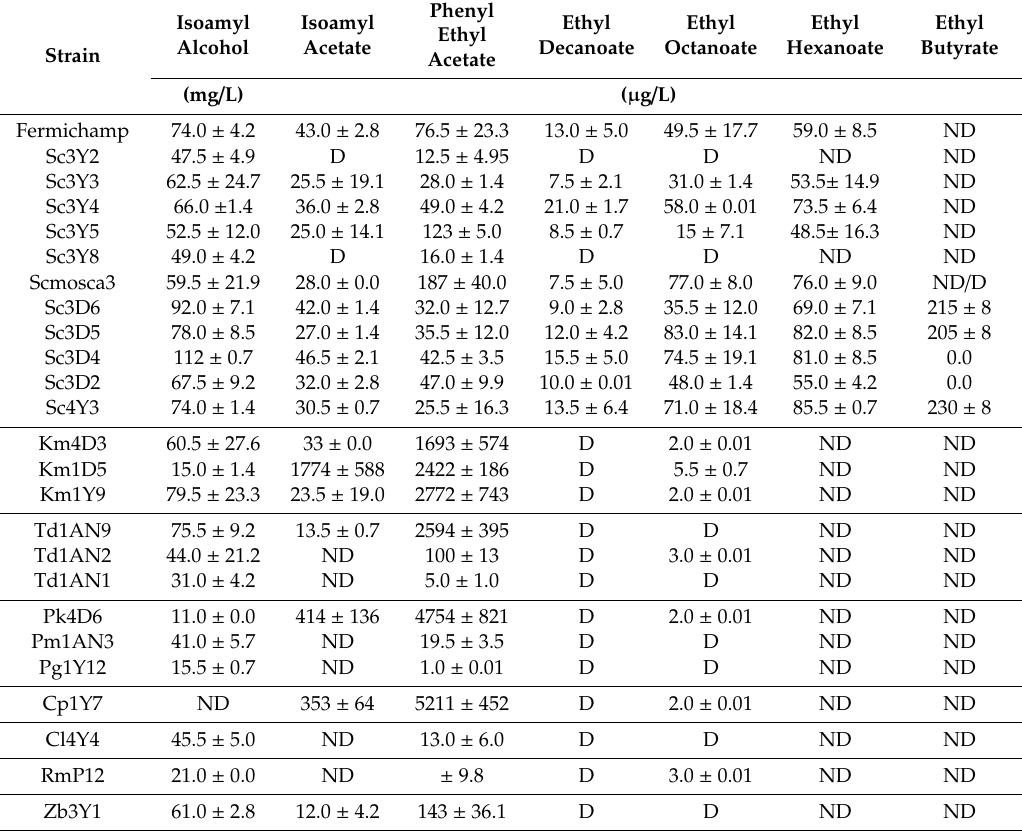
Table 3. Volatile profiles of all mezcal yeast tested at 96 h of fermentation in synthetic medium M3, 200 g / L of initial